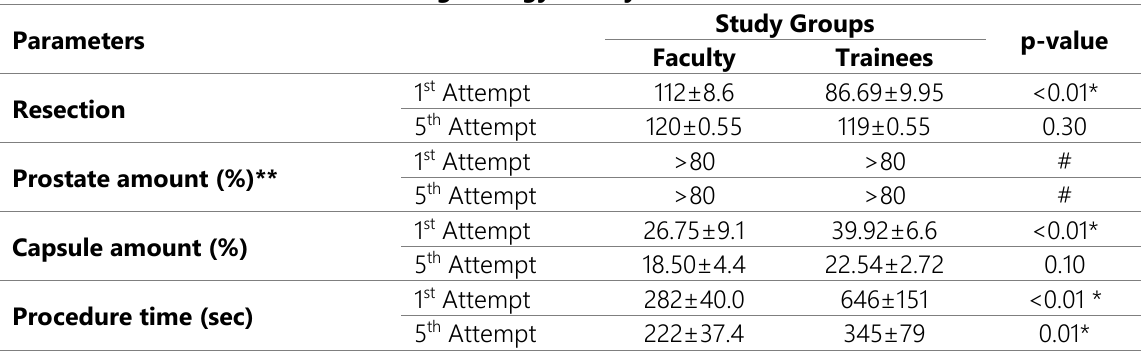
Table 1: Comparative findings of Simulative TURP – Resection among urology faculty & trainees.